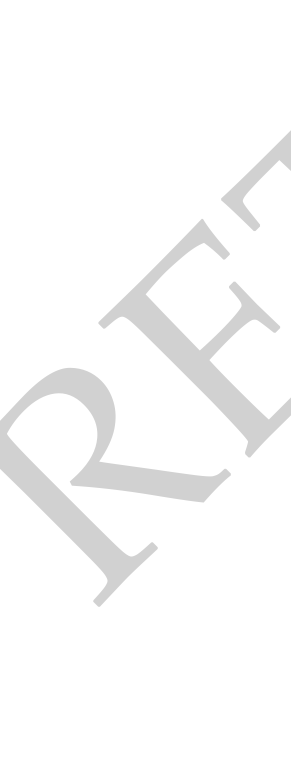
Figure 3. The selected optical micrographs obtained at t c2 = 15 min after fiber pulling with different pulling rates at 170 °C: ( a ) 12.5 μ m /s; ( b ) 62.5 μ m /s; ( c ) 180 μ m /s; ( d ) 625 μ m /s. The fiber-pulling distance was 250 μ m and the same pulling direction was marked in ( b ).